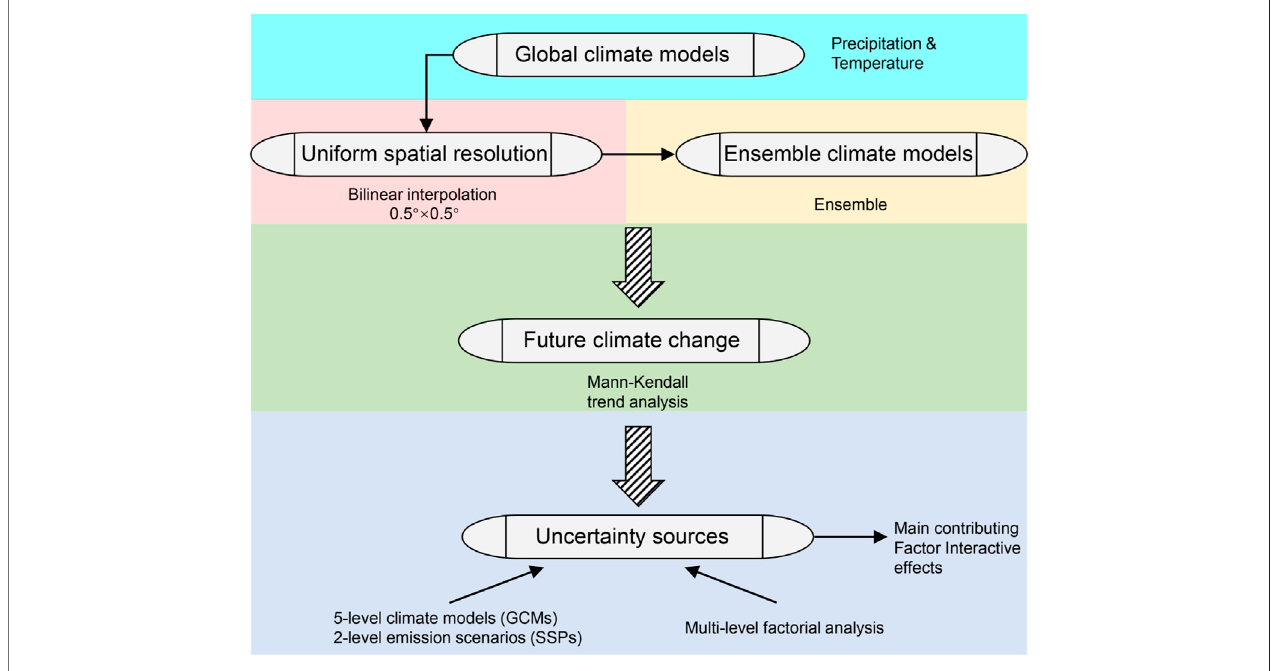
FIGURE 2 | The fl owchart of this